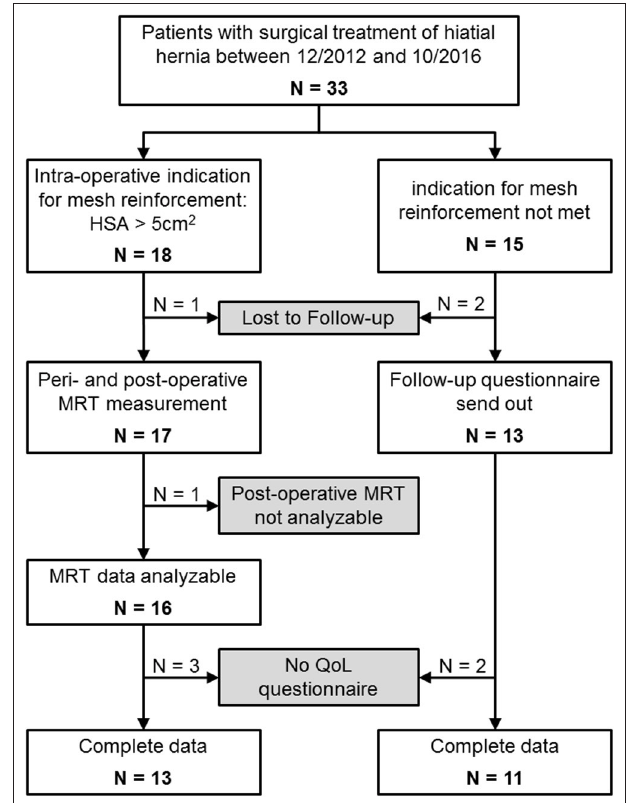
FIGURE 3 | Flow chart of the study